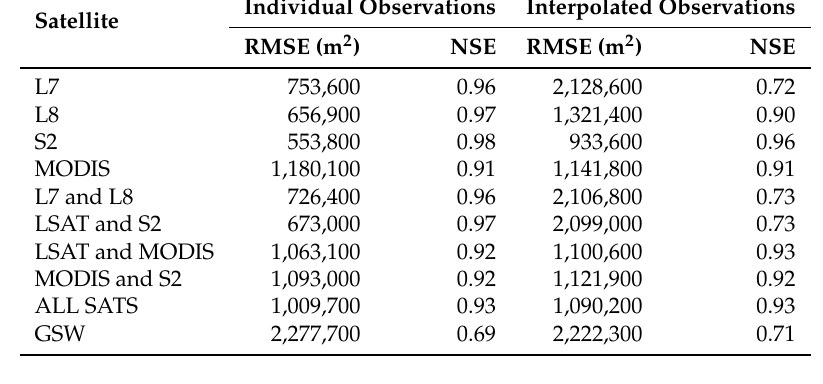
Table 6. RMSE and NSE between remotely sensed flooded areas and ground truth data and daily interpolated areas from each sensor and multi-sensor combinations (1999–2019).